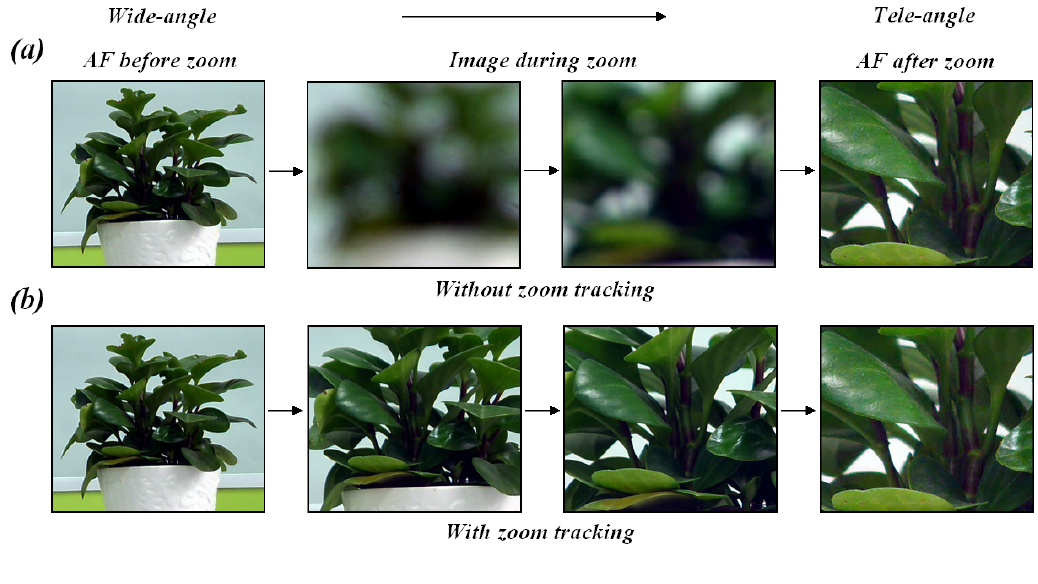
Figure 1. Illustration of the zoom tracking